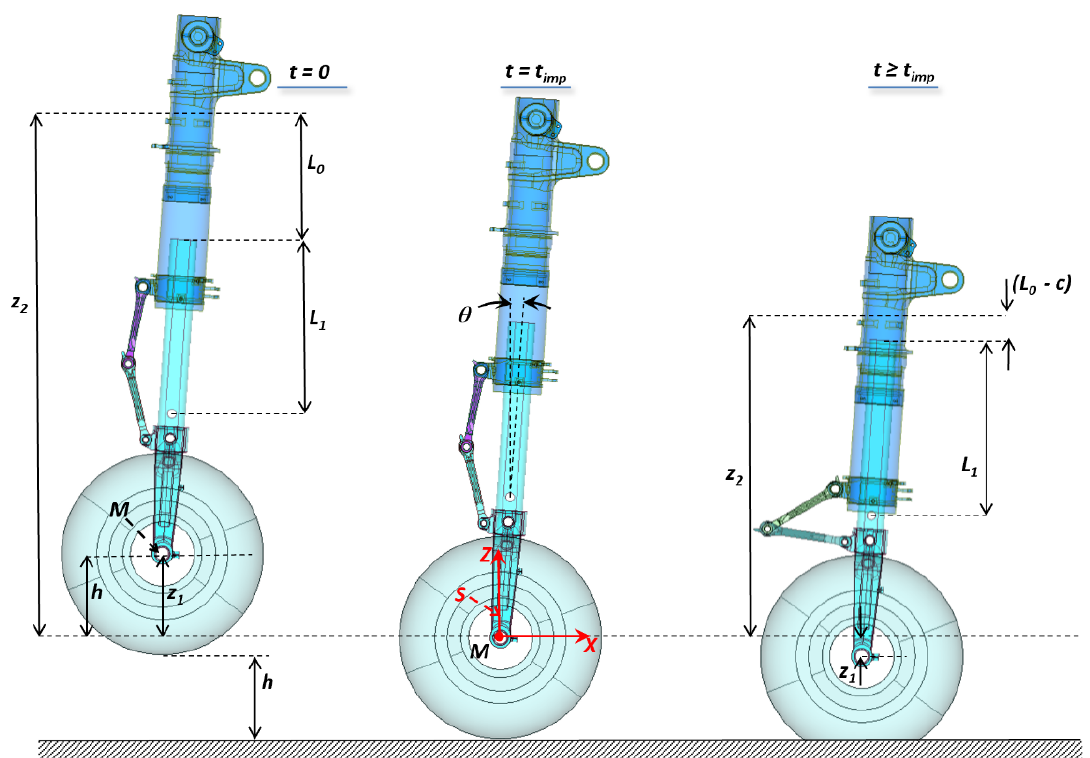
Figure 4. Phases of landing gear drop and main parameters involved in impact dynamics (telescopic arrangement, typical of nose landing gear).